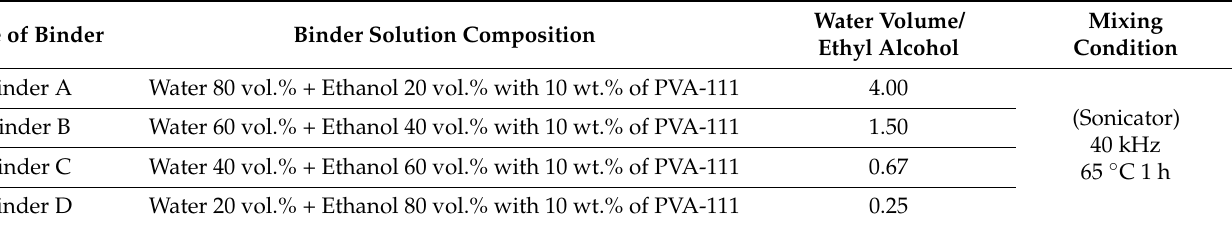
Table 2. Compositions of the binder solutions.